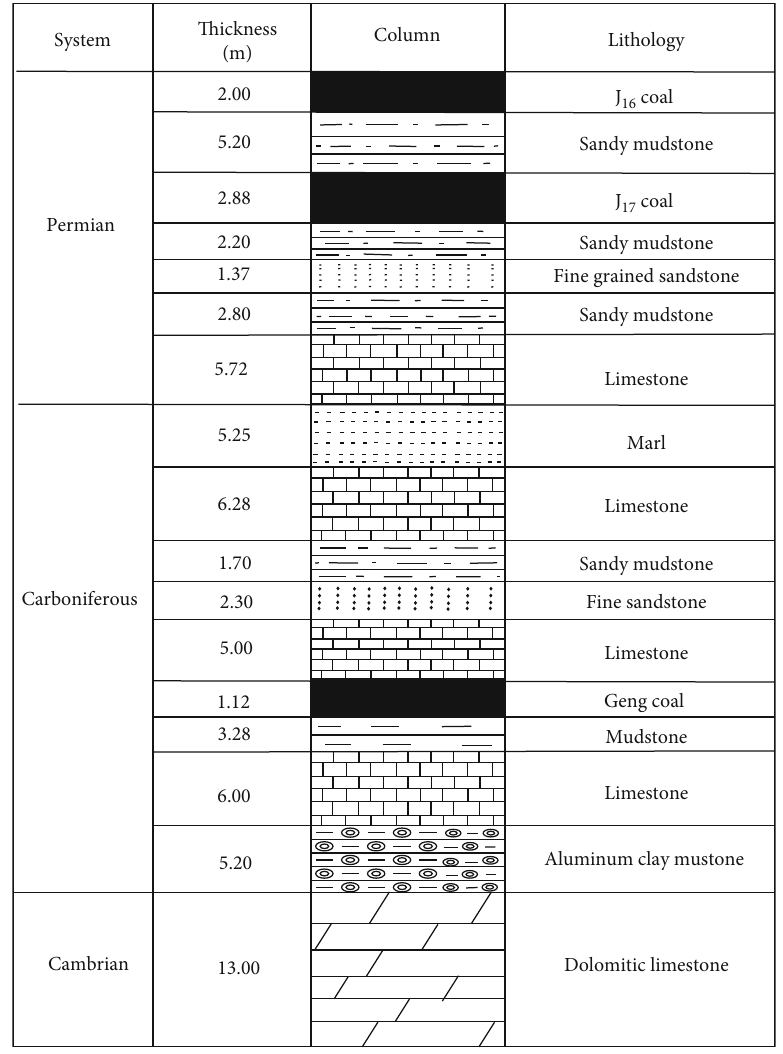
Figure 1: Column diagram of coal fl oor of the J